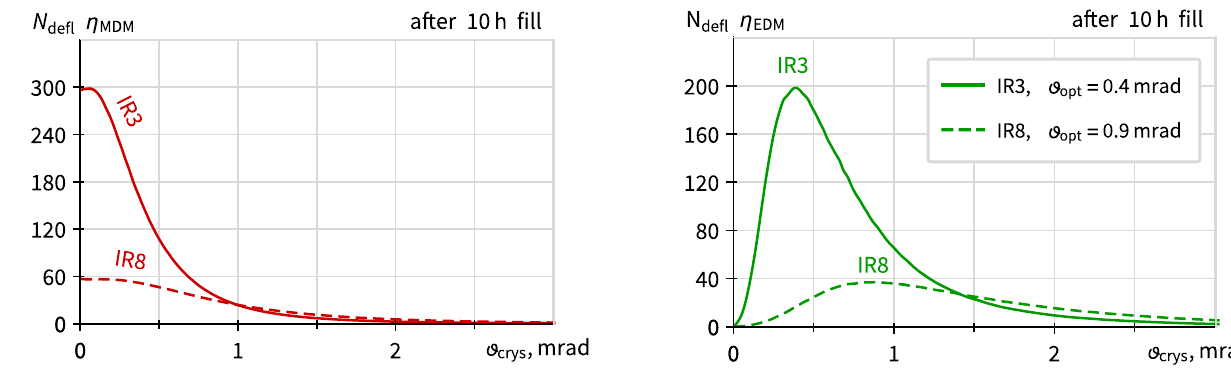
Fig. 5 Precession efficiency (left) of MDM and (right) of EDM measurements as a function of crystal orientation ϑ crys . The same configurations as in Fig. 4